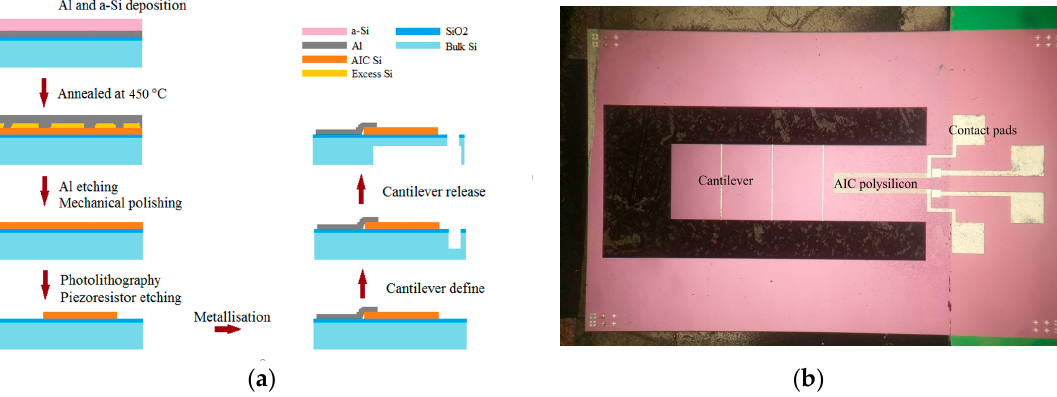
Figure 1. ( a ) Fabrication process of AIC polysilicon and the test structure; ( b ) Optical image of the cantilever with polysilicon on top.